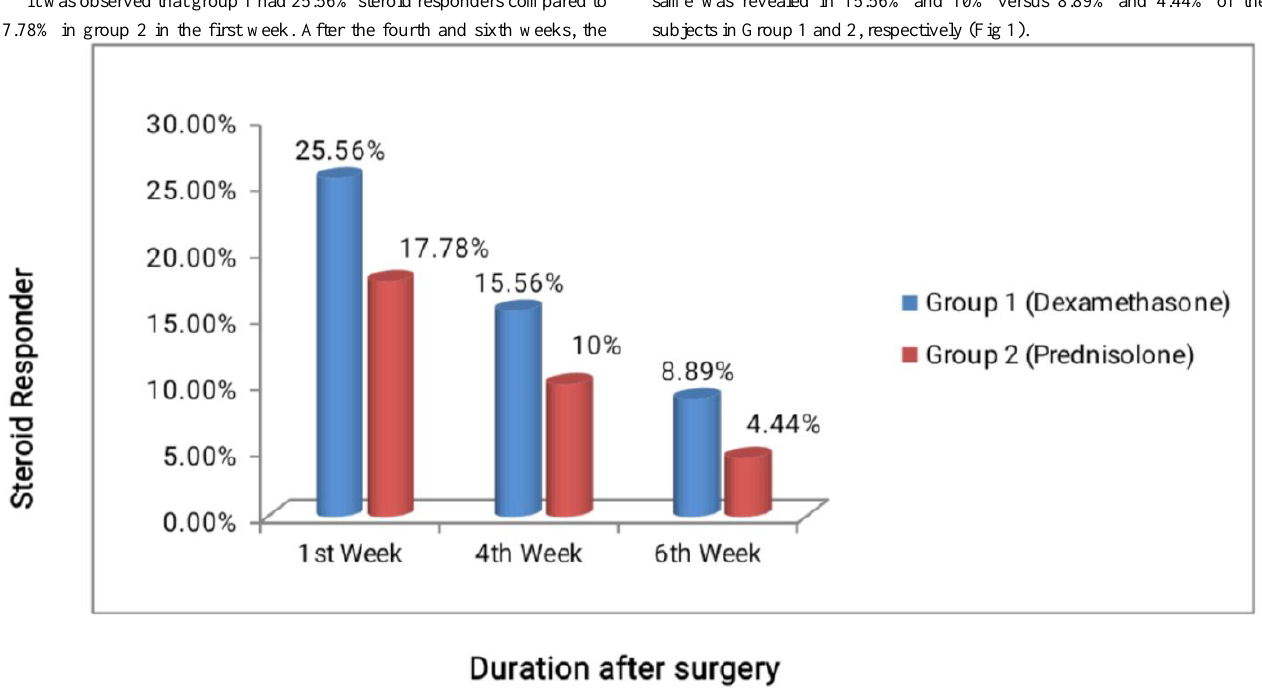
Fig. 1. Steroid responder among the study groups at different follow-ups.